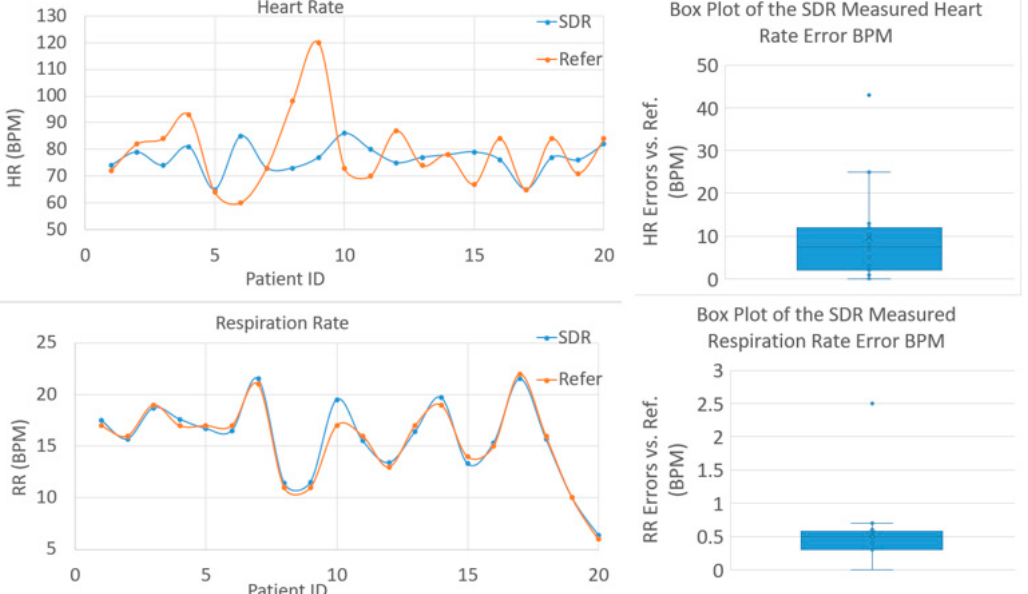
Figure 9. Data analysis on the HR/RR measured by our NCVS sensor system vs. the references on 20 test cases of real patients during the clinical trial.